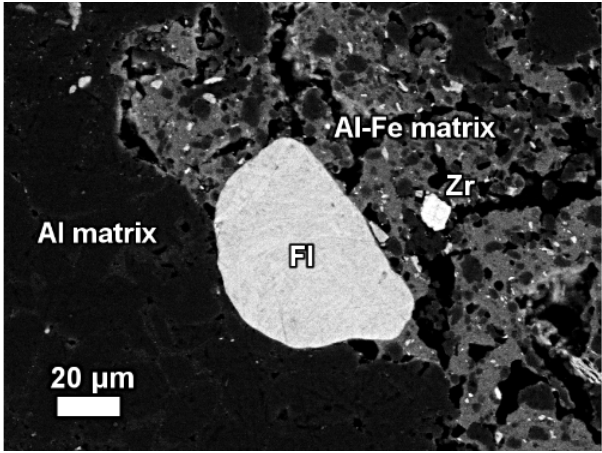
Figure 3. Florencite group LREE phase (Fl) and a zircon grain (Zr) in Ghanaian lateritic bauxite matrix.